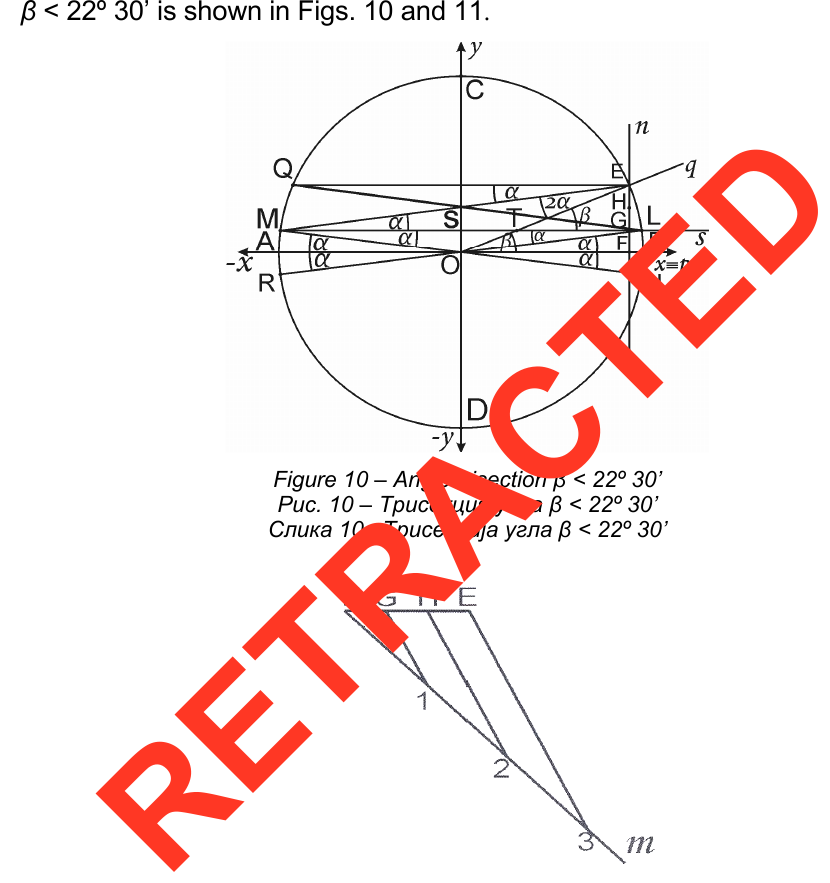
Figure 11 – Division of the length FE for the angle trisection of β < 22º 30’ Рис . 11 – Длина деления отрезка FE по трисекции угла β < 22º 30’ Слика 11 – Подјела дужи FE за трисекцију угла β < 22º